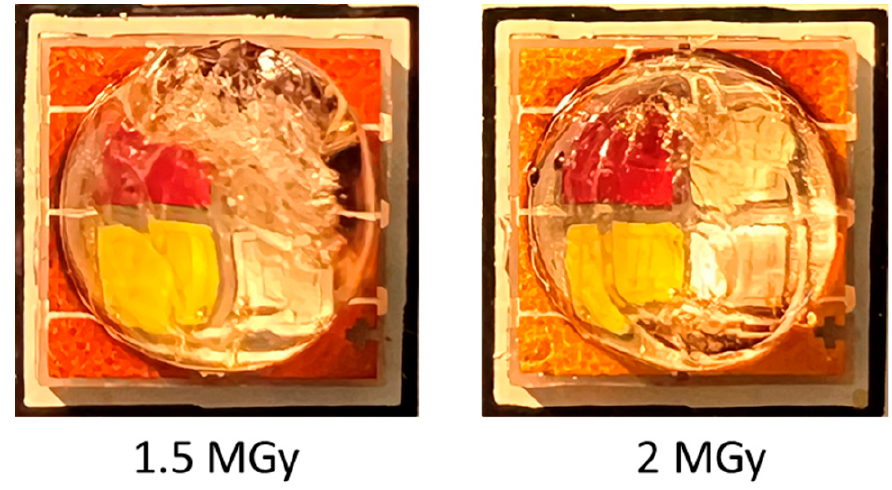
Figure 6. Frontal photography of the two damaged samples, where the damage of the lenses is clearly visible. Sample I05M1 (on the left) and sample I1M2 (on the right).